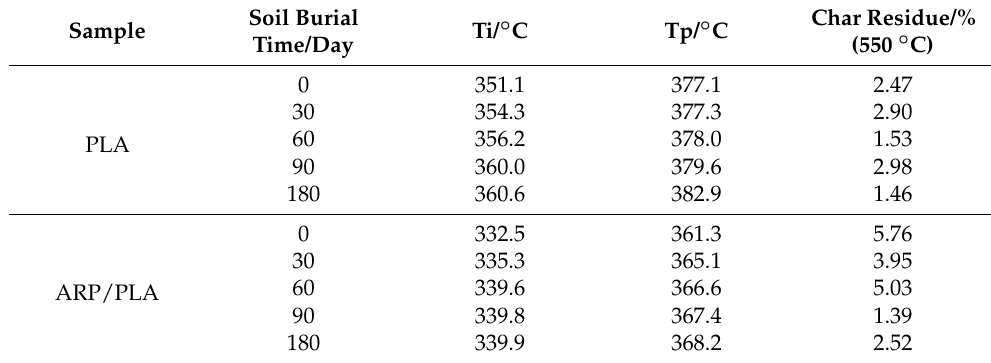
Table 1. Thermogravimetric analysis information for different specimens.